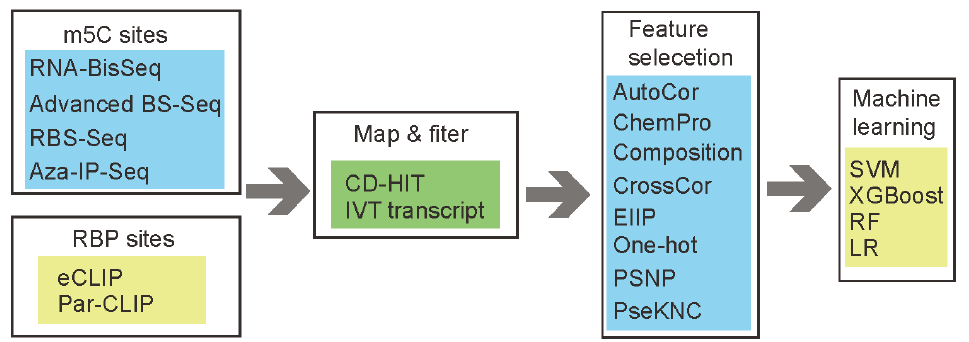
Figure 1. The workflow for m5CRegpred. The methylation sites and RNA Binding proteins (RBP) sites were obtained from four and two types of sequencing techniques, respectively. Eight kinds of encoding methods were considered in the project.